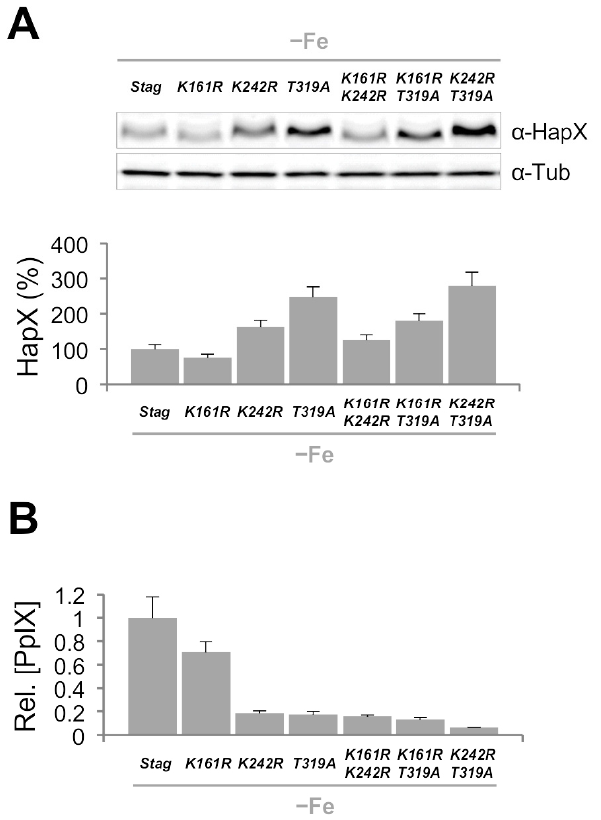
Figure 9. K242 and T319 are important in the regulation of HapX protein levels. ( A ). HapX quantification by Western blot analysis. Samples were obtained from the indicated strains grown under − Fe conditions as in Figure 2A. Upper panel: Representative Western blot analysis showing HapX protein levels. α -Tubulin was used as loading control. Lower panel: Densitometric protein quantification. HapX protein levels were normalized to Tubulin and expressed relative to those in − Fe. ( B ). Quantification of PpIX in − Fe conditions. PpIX levels were normalized to the amount of total protein and expressed relative to those in hapX s . Bars represent standard deviations from two independent biological experiments with two technical replicates